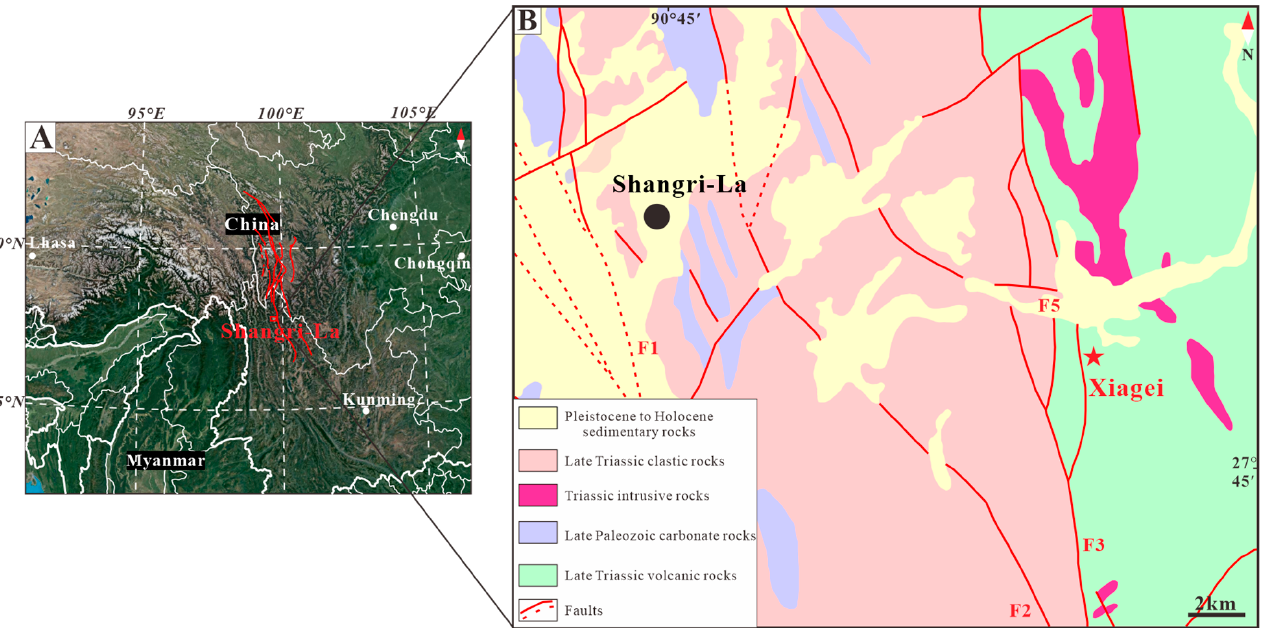
Figure 1. ( A ) Location of the Shangri-La area, northwest of Yunnan Province (China); Red lines: Jinshajiang fault zone. ( B ) Geologic map of Xiagei and surrounding region (modified from Zheng [32]). F2: NWW-SEE-striking Yanggu fault zone, F3: N-S striking Gezanhe-Are reverse fault zone, F5: near E-W trending Tianshengqiao reverse fault zone.